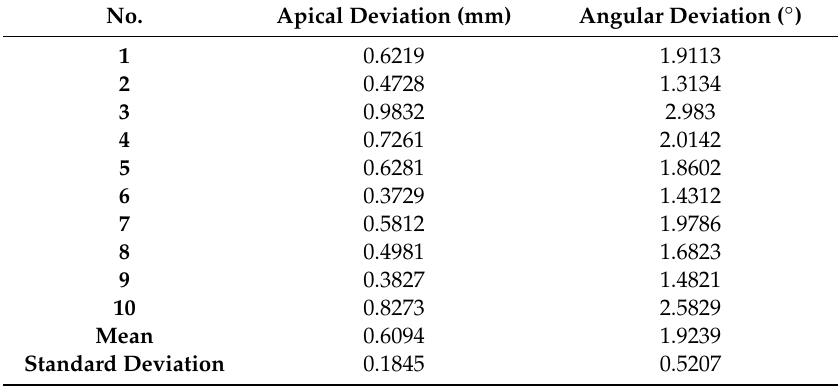
Table 2. Apical and angular deviations between the planned implant fixture and the placed implant fixture of the surgical guides fabricated with the R2gate